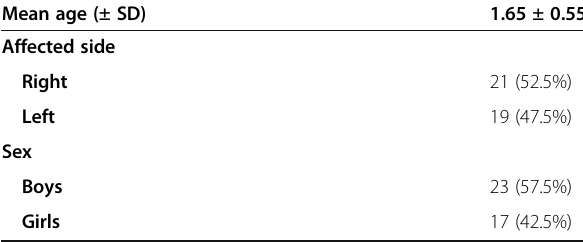
Table 1 General characteristics of the study